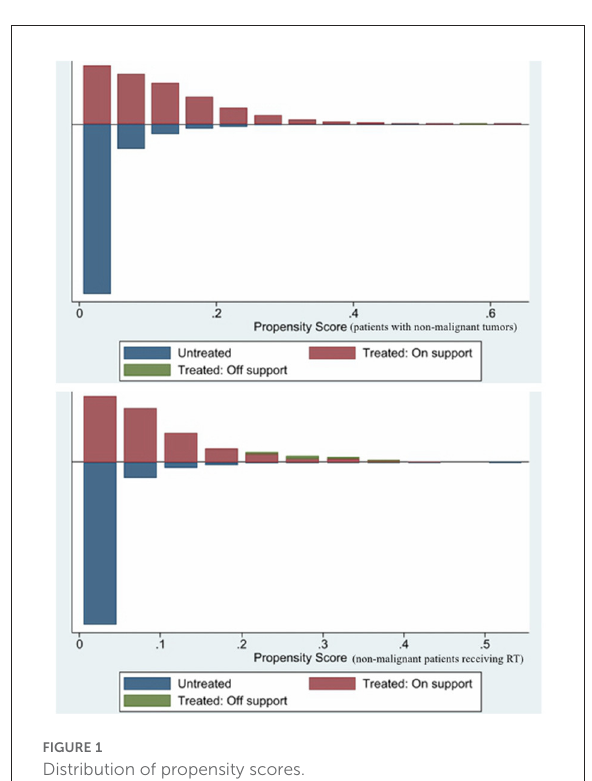
FIGURE1 Distribution of propensity